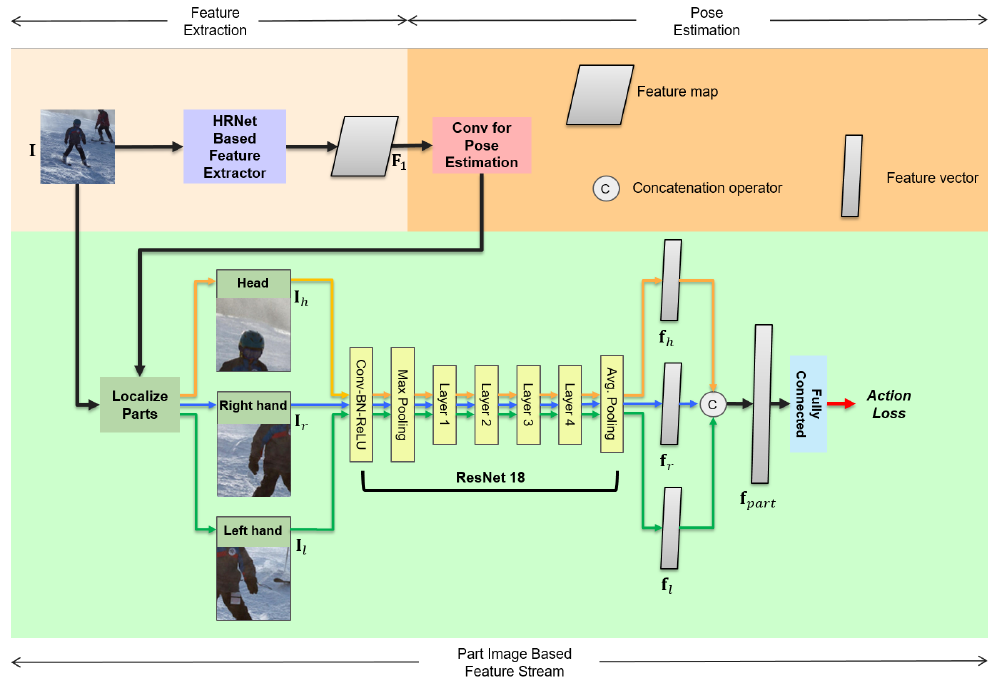
Figure 4. Part-image-based feature stream. The figure depicts the shared feature extractor, pose estimation, and part-image-based feature stream shown in Figure 1. The background colors are the same as Figure 1.